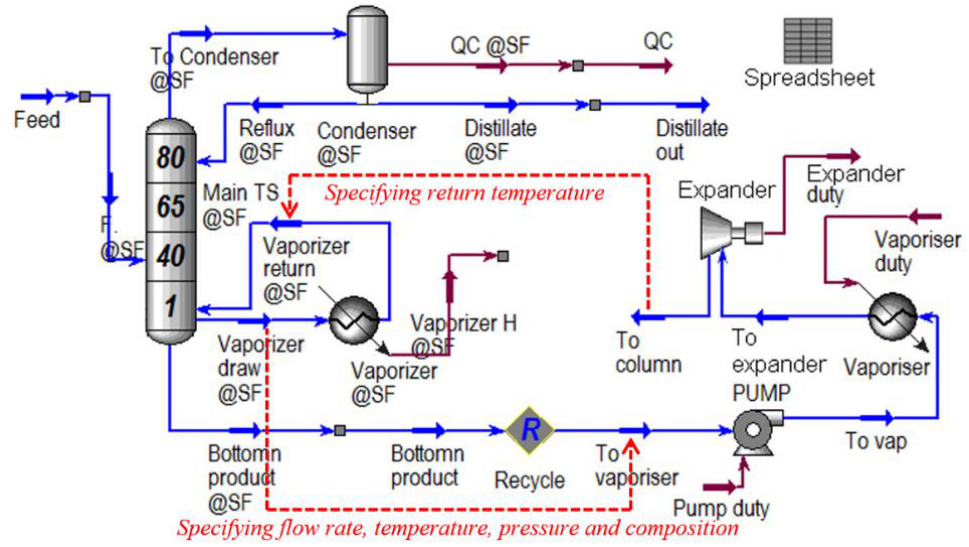
Figure A1. Model of turboexpander integrated to distillation column with an external simulation of power generation system.